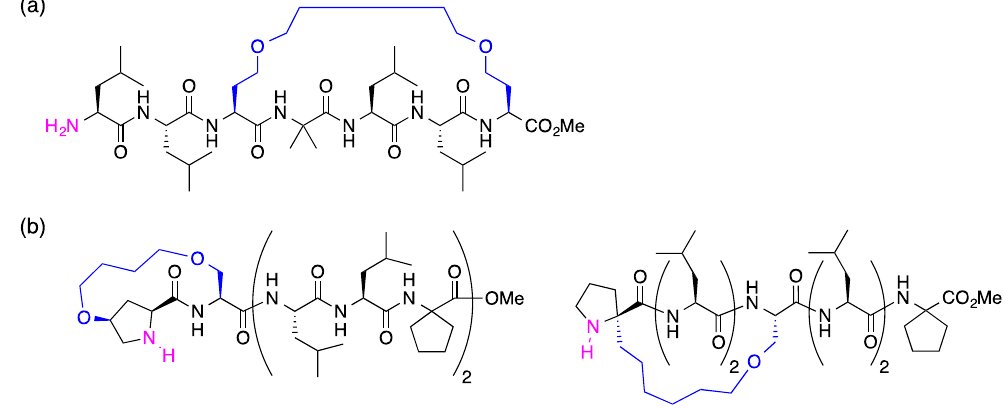
Figure 1. Hydrocarbon-stapled peptides used in the organocatalytic reaction. ( a ) Helical peptide-based primary amino catalyst with stapling at i , i + 4 and ( b ) helical peptide-based secondary amino catalysts with stapling at i , i + 1 and i , i + 3 (This work).